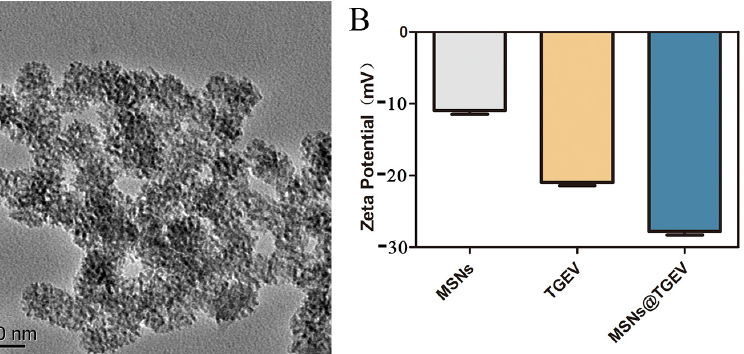
Figure 1. Morphology of MSNs and Zeta potential measurements. ( A ) The uniform spherical of MSNs was confirmed by TEM. ( B ) The complex of inactivated TGEV vaccine with MSNs was investigated by Zeta potential measurement.